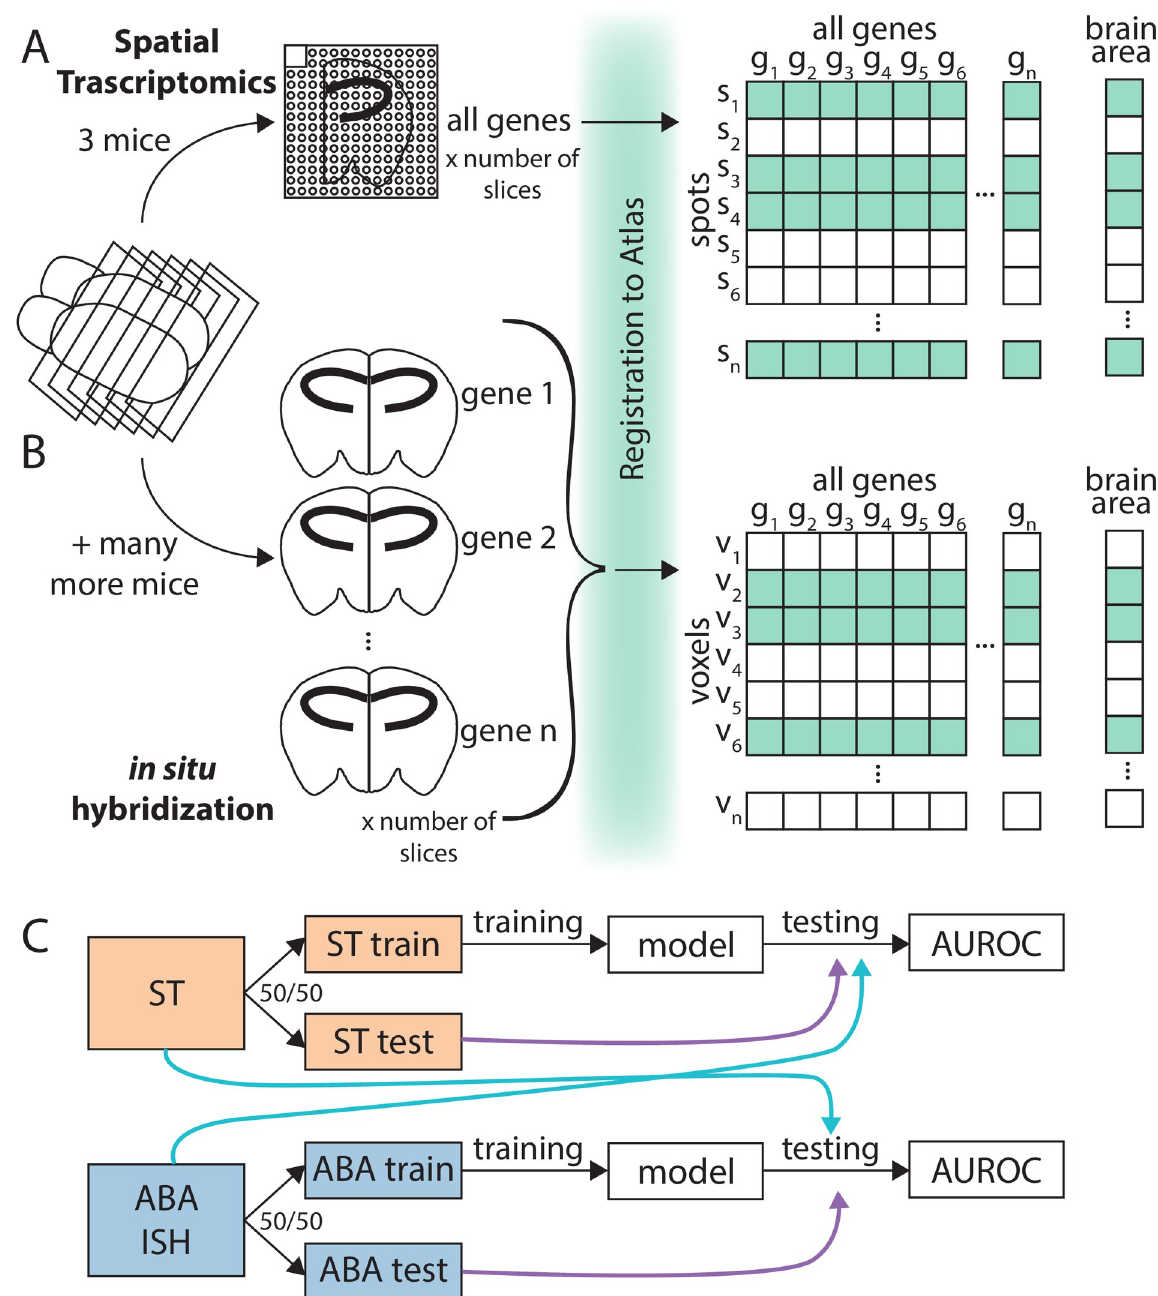
Fig 1. Collection and processing of spatial gene expression datasets. (A) Schematic depicting workflow of collecting whole-brain spatial gene expression using ST. Illustration depicts sectioning of mouse brain, tissue from one hemisphere on one ST slide, registration to ARA, and a layout of the collected data. (B) Schematic depicting workflow of collecting Allen Institute’s whole-brain spatial gene expression using ISH (ABA). Illustration depicts similar workflow to (A), but instead of ST capturing all genes in one (3 for this dataset) brain, there were many more mice used to collect the whole-transcriptome dataset since each brain tissue slice can only be used to probe one gene. (C) Schematic illustrating classification schema. The ST dataset from (A) (orange) and ABA dataset form (B) (blue) were split into 50/50 train/test folds. The training fold was used for model building and the test fold for evaluating the trained model within dataset (purple arrow). Later analysis also applied models trained using the train fold of one dataset to the opposite dataset for testing (light blue arrow). ABA AU : AbbreviationlistshavebeencompiledforthoseusedinFigs 1 (cid:0) 5 : Pleaseverifythatallentriesarecorrect : , Allen Brain Atlas; ARA, Allen Reference Atlas; AUROC, area under the receiver operating curve; ISH, in situ hybridization; ST, spatial transcriptomics.